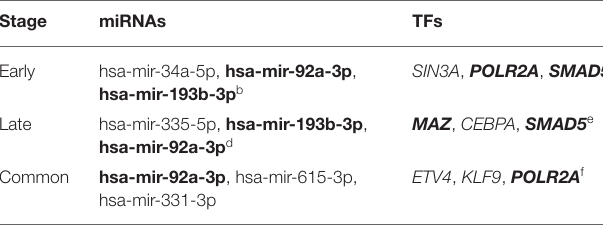
TABLE 3 | Top 3 miRNAs or TFs closest to hub genes a